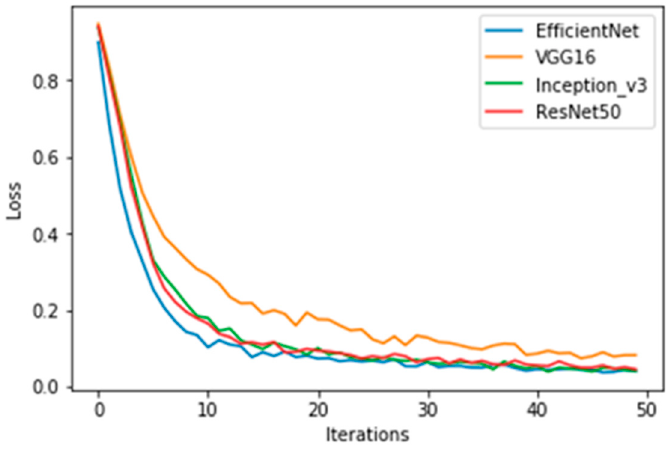
Figure 7. Evolution of loss function for the EfficientNet, ResNet50, Inception_v3, and VGG16.